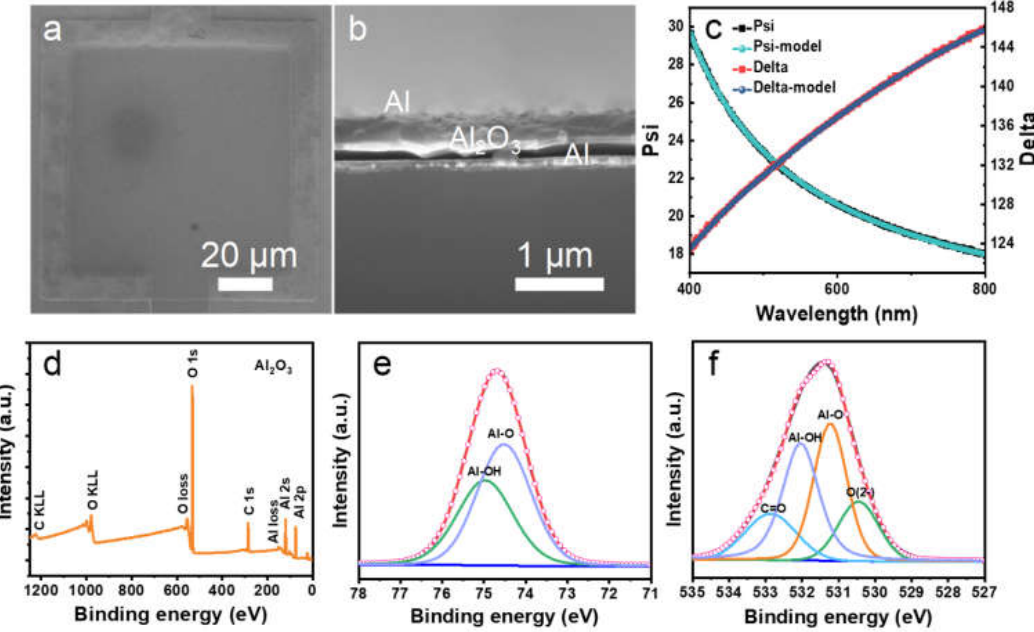
Figure 2. ( a ) SEM image of the Al 2 O 3 -based MIM capacitor. ( b ) The cross-sectional SEM image of the MIM capacitor. ( c ) The 25 nm Al 2 O 3 film thickness test results obtained by ellipsometry spectrometer: where Psi represents the amplitude ratio, and Delta represents the phase difference. ( d ) XPS survey spectra of the prepared Al 2 O 3 film. High-resolution XPS spectra of ( e ) Al 2p, ( f ) O 1s.